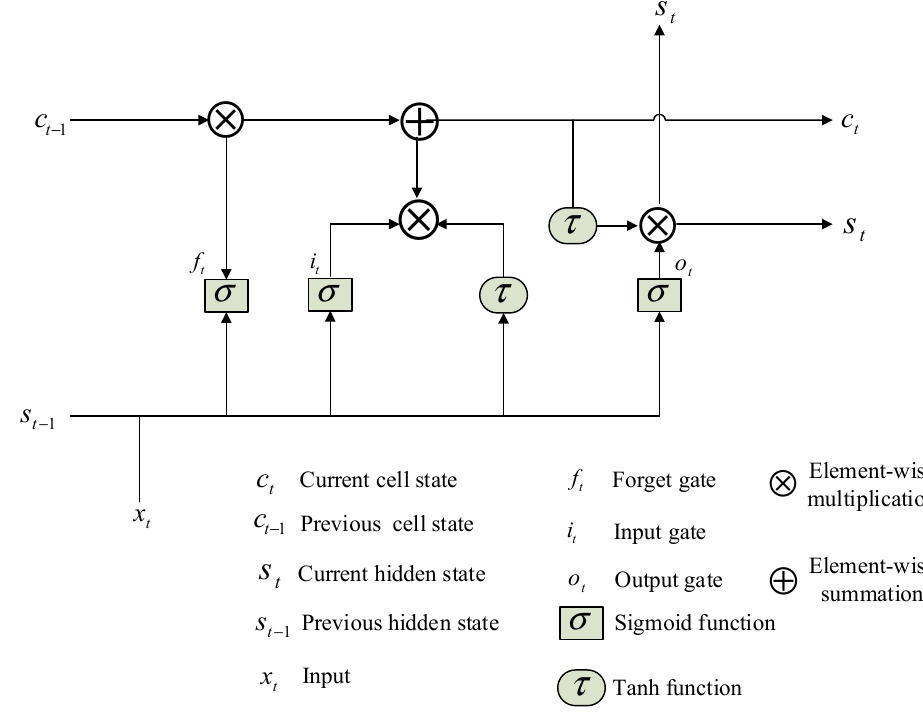
Figure 3. The structure of a long short-term memory cell.